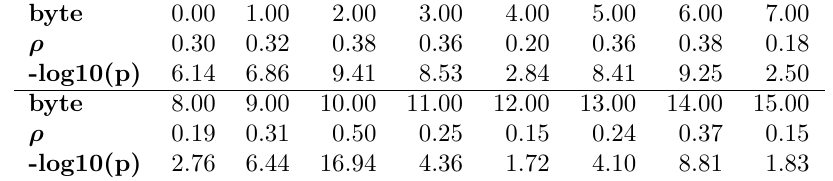
Table 8: Correlation among profiles (byte by byte for POI 0) between optimized and non-optimized traces.